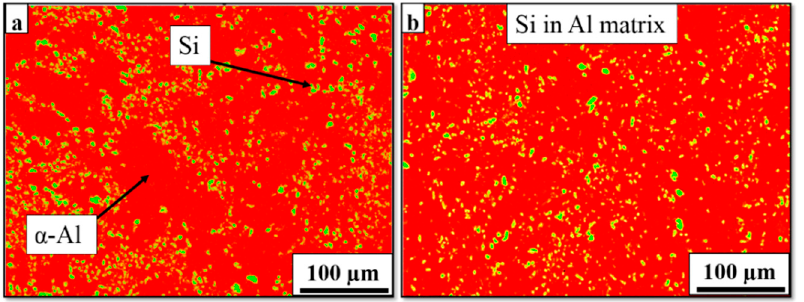
Figure 5. Mapping of the HPTed A356 Al alloy post-T6 at the ( a ) centre and ( b ) edge by 5 turns.